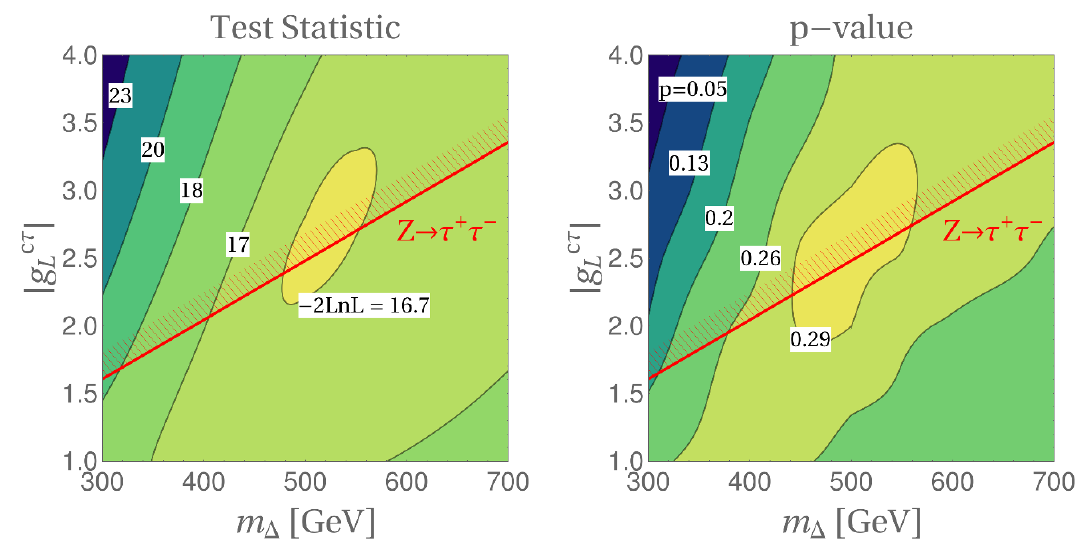
Figure 12 . Summary of the best (cid:12)t analysis of LQ models characterized by the values of m (cid:1) and g c(cid:28) . These results are based on the minimization of the test statistic de(cid:12)ned in eq. (4.1) with j j respect to (cid:13) and C 0 using the IceCube 6-year data sample. In the left panel we show contour lines for the values of the test statistic, while in the right panel we also plot contour lines but considering the obtained p-value. We show in both (cid:12)gures the exclusion coming from the Z -pole observables discussed in section